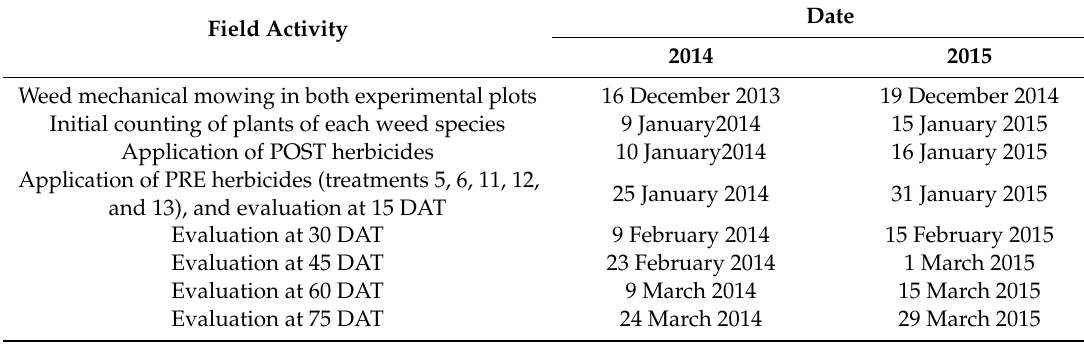
Table 5. Summary of activities conducted for weed control with pre- (PRE) and post-emergence (POST) herbicides in two Persian lime groves of the “San Manuel” Farm, Puebla, Mexico.